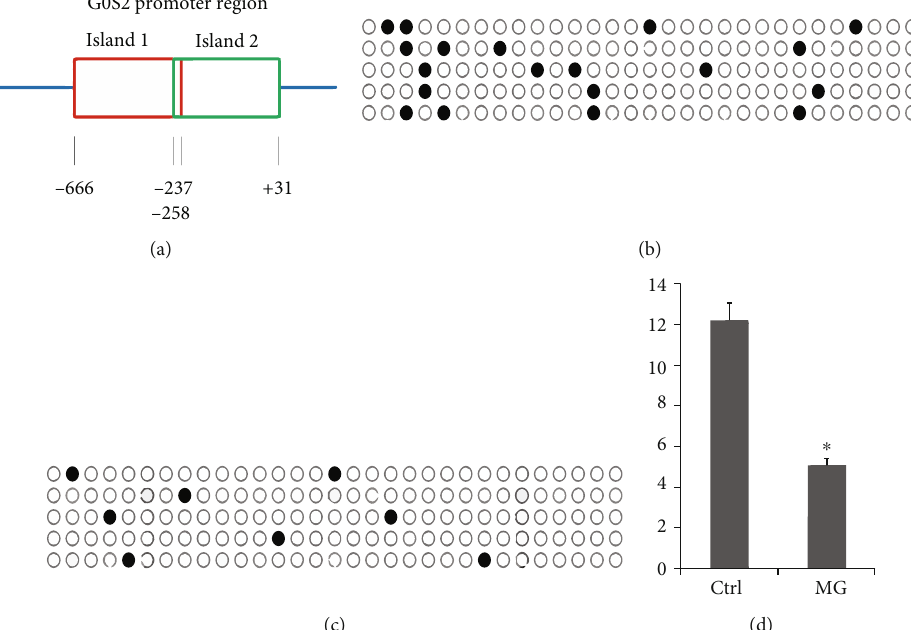
Figure 2: G0S2 methylation level in control and MG patients. (a) The positions of two di ff erent CpG islands in G0S2 promoter region. Box represents the di ff erent CpG islands. Number represents the positions of nucleobase. (b) G0S2 methylation density in the control group; blank circle means result which was not methylation; the black circle means methylation result. (c) G0S2 methylation density in the MG patients. Blank circle means result which was not methylated; the black circle means methylation result. (d) Normalized ratio of G0S2 methylation. MG means the myasthenia gravis patients; ctrl means healthy volunteers. The y -coordinate represents the rate of methylation result.